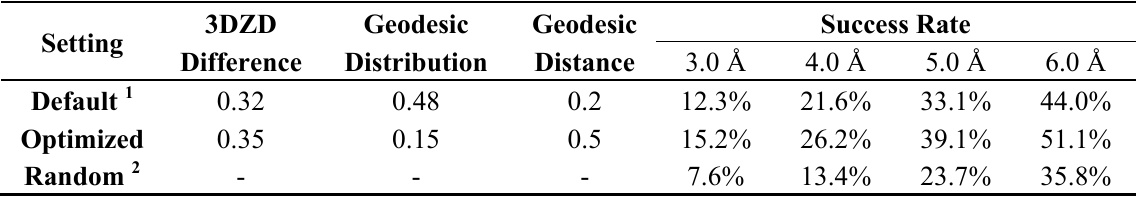
Table 2. Coefficients and the success rate of different distance score functions.